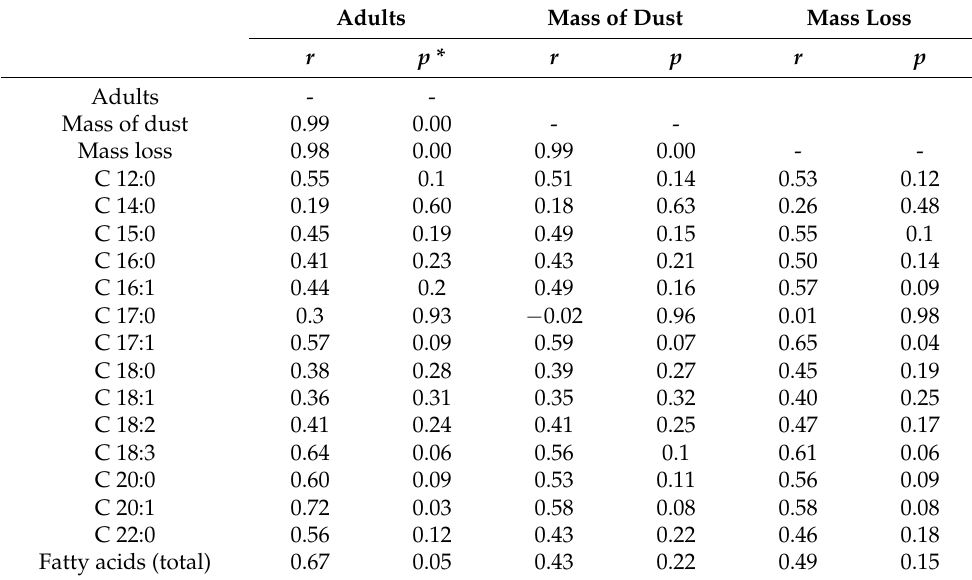
Table 4. Values of Pearson’s linear correlation coefficient r between the analysed parameters of the development of S. granarius population and the content of fatty acids. Adults Mass of Dust Mass Loss